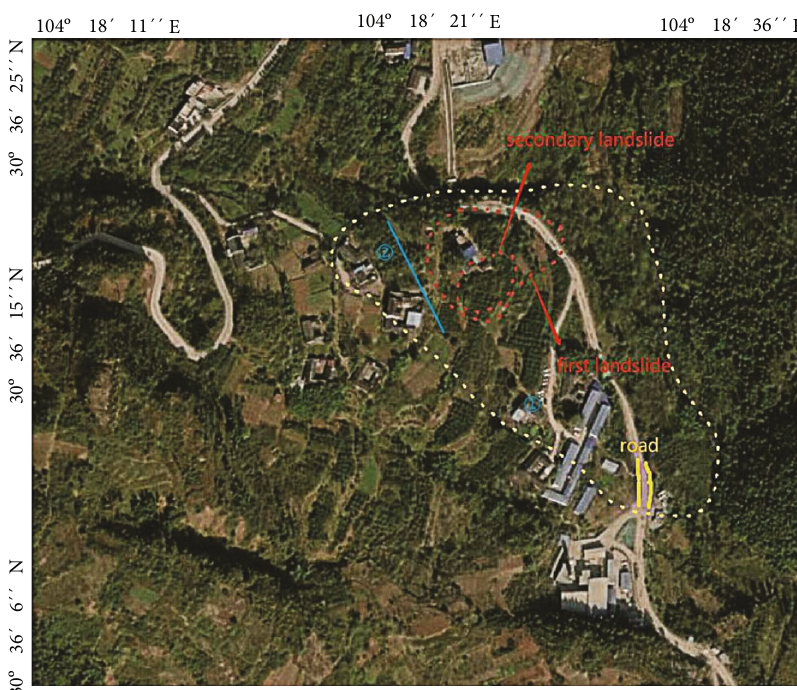
Figure 5: Satellite image before the landslide. The red dotted line indicates the area of the fi rst landslide and the second landslide. The yellow dotted line indicates the entire study area.